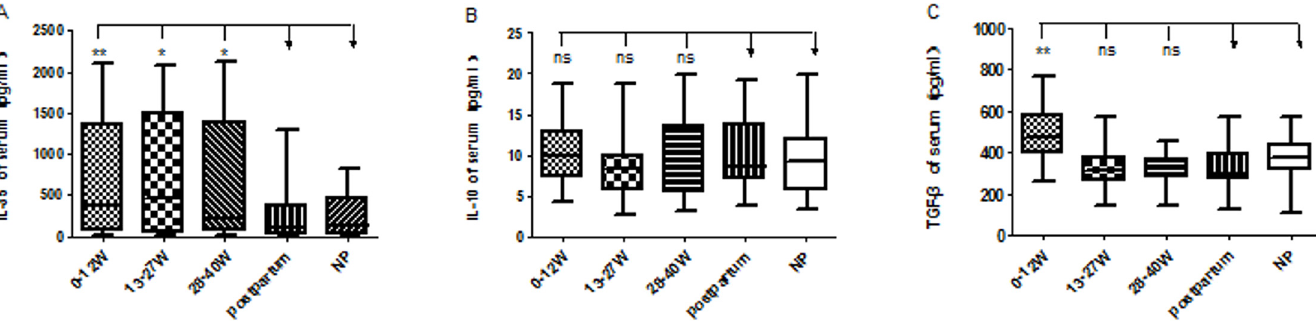
Fig 2. The serum levels of inhibitory cytokines (A) IL35, (B) IL10, and (C) TGF- β at different stages of pregnancy. 0 – 12 weeks: first trimester; 13 – 27 weeks: second trimester; 28 – 40 weeks: third trimester. NP: non-pregnant women; postpartum: postpartum healthy women; * P < 0.05; ** P < 0.01; ns: not significant.